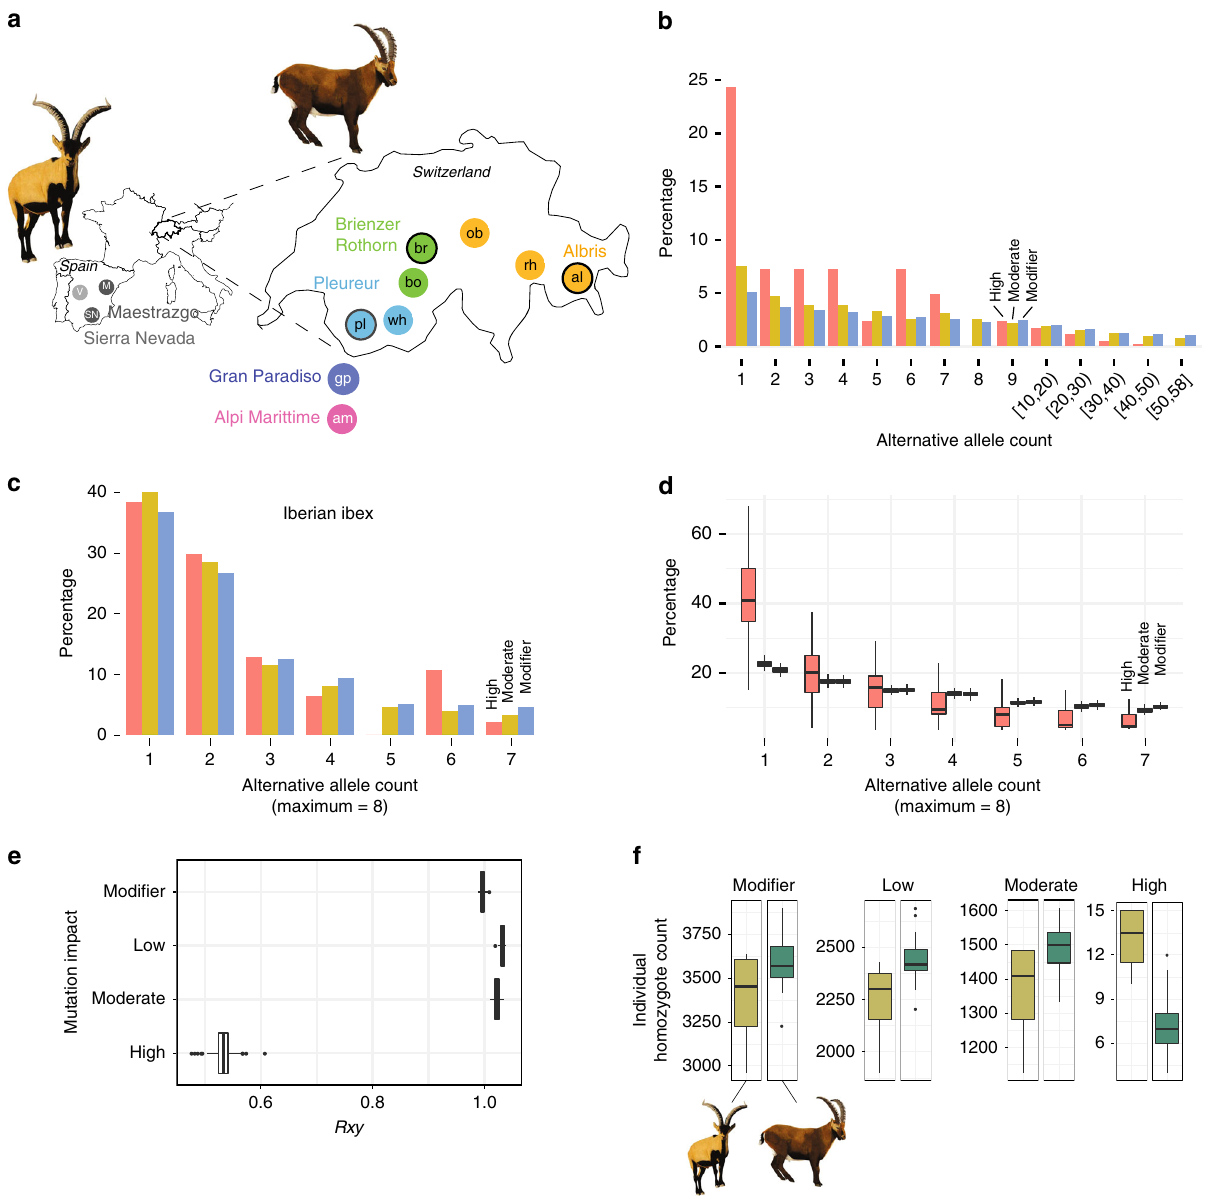
Fig. 2 Deleterious mutations segregating in Alpine and Iberian ibex. a Population sampling locations of Iberian ibex (left, gray circles) and Alpine ibex (right, colored circles). Each fi lled circle represents a population. Circles with a black outline indicate the fi rst three reintroduced populations in Switzerland that were used for all subsequent population reintroductions of Alpine ibex. Colors associate founder and descendant populations (see also Fig. 3a). b Site frequency spectrum for neutral (modi fi er), mildly (moderate impact) and highly deleterious (high impact) mutations for Alpine ibex. Alternative allele counts > 10 are shown as mean counts per interval. c Site frequency spectrum for Iberian ibex. d Site frequency spectrum for Alpine ibex downsampled to four individuals matching the sample size of Iberian ibex (100 replicates). See Figure S11 for additional downsampling and jack-kni fi ng analyses of data presented in ( b – d ). e Rxy analysis contrasting Iberian with Alpine ibex across the spectrum of impact categories. Rxy < 1 indicates a relative frequency de fi cit of the corresponding category in Alpine ibex compared to Iberian ibex. Rxy distributions are based on jack-kni fi ng across chromosomes. All pairwise comparisons were signi fi cant except low vs. moderate (Tukey test, p < 0.0001). f Individual homozygote counts per impact category for Iberian (light green) and Alpine ibex (dark green). Boxplots elements are de fi ned as in Fig. 1. Source data are provided as a Source Data fi